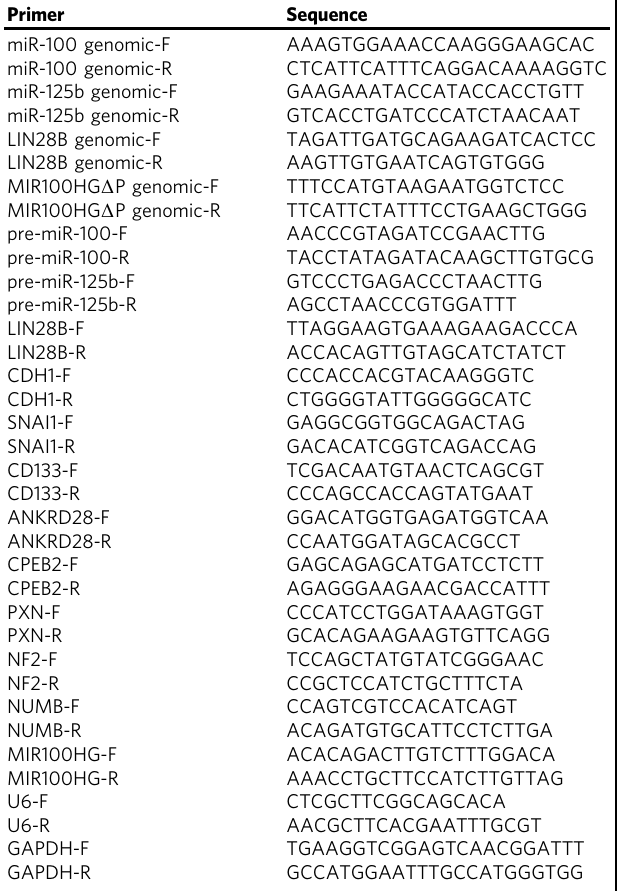
Table 2 PCR primers used in this study Primer Sequence miR-100